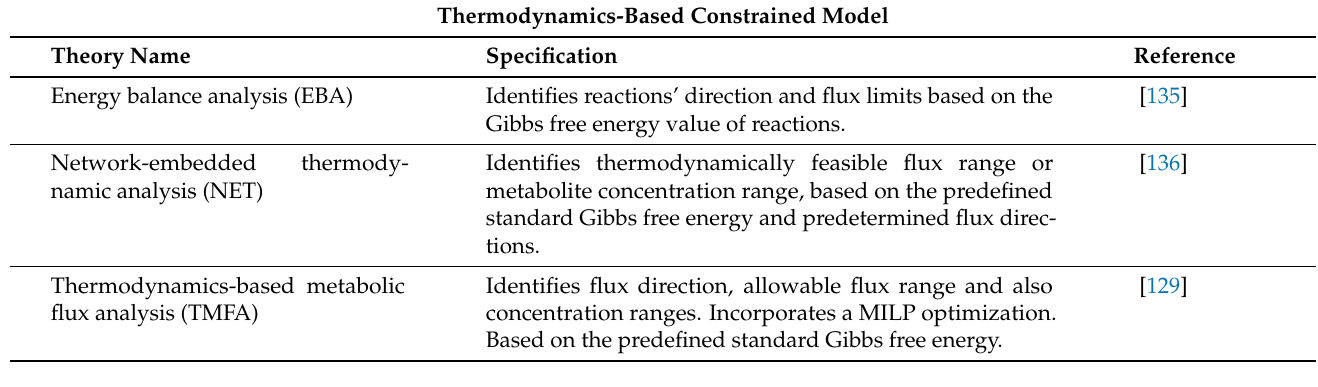
Table 1. Thermodynamically constrained models along with their specifications and reference to their origin.